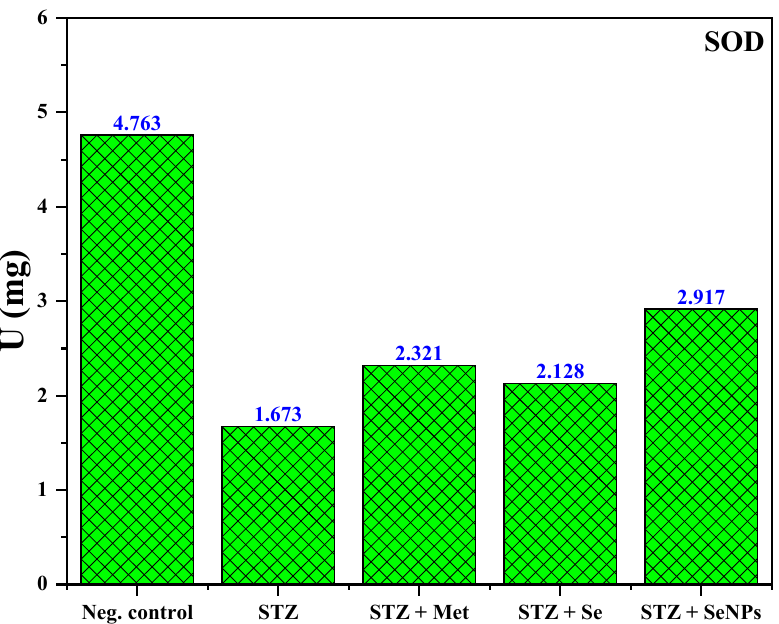
Figure 11. Super oxide dismutase level on control and treated groups.